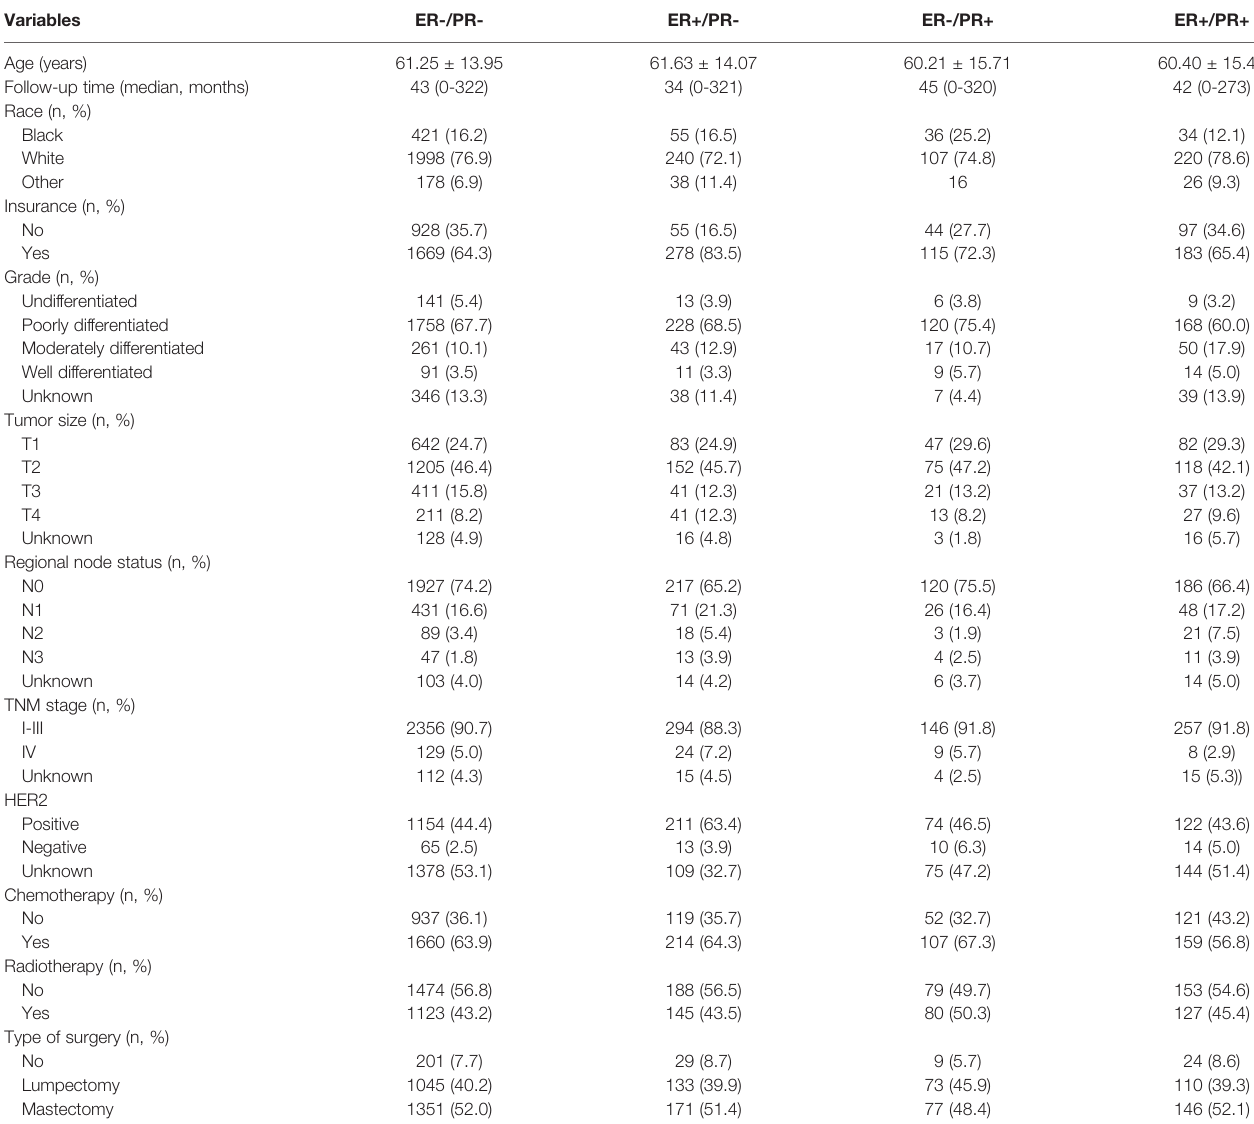
TABLE 1 | Characteristics in MBC patients with ER-/PR-, ER+/PR-, ER-/PR+, and ER+/PR+